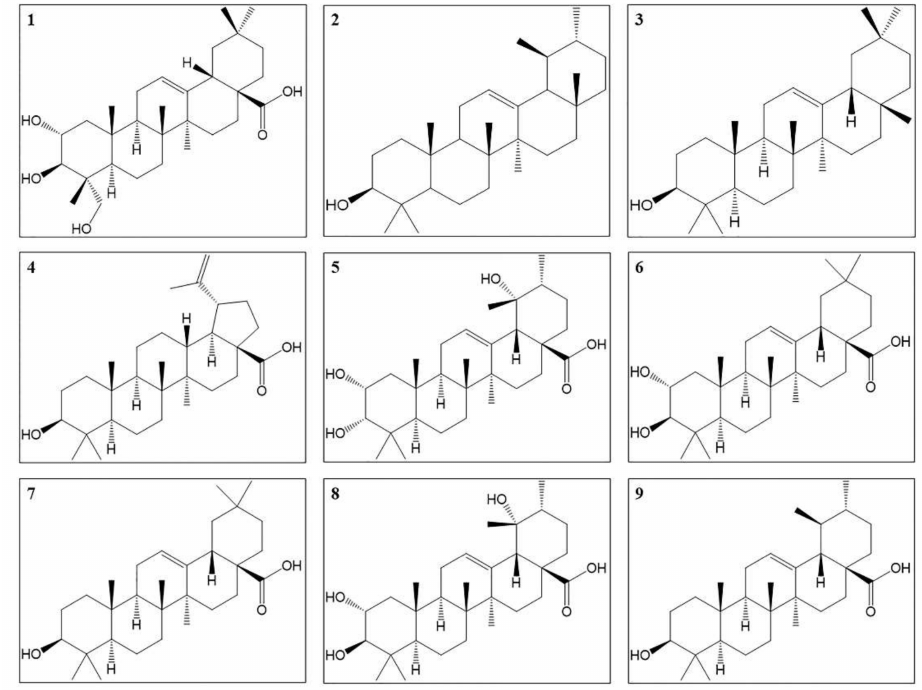
Figure 4. Structures of triterpenoids with antidiabetic effects; ( 1 ) Arjunolic acid, ( 2 ) α -Amyrin, ( 3 ) β - Amyrin, ( 4 ) Betulinic acid, ( 5 ) Euscaphic acid, ( 6 ) Maslinic acid, ( 7 ) Oleanolic acid, ( 8 ) Tormentic acid and ( 9 ) Ursolic